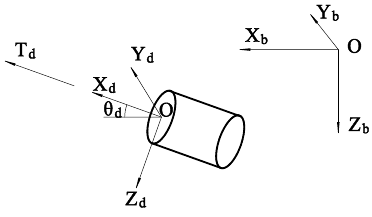
Figure 6. Diagram of force and geometry of lift duct.